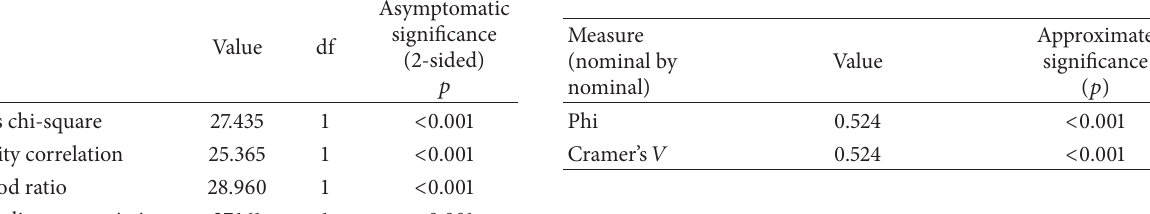
Table 2: Symmetric measures. Phi and Cramer’s 𝑉 were calculated to assess strength of association between the two dichotomous variables, Sacroiliac joint dysfunction, and history of Lumbar